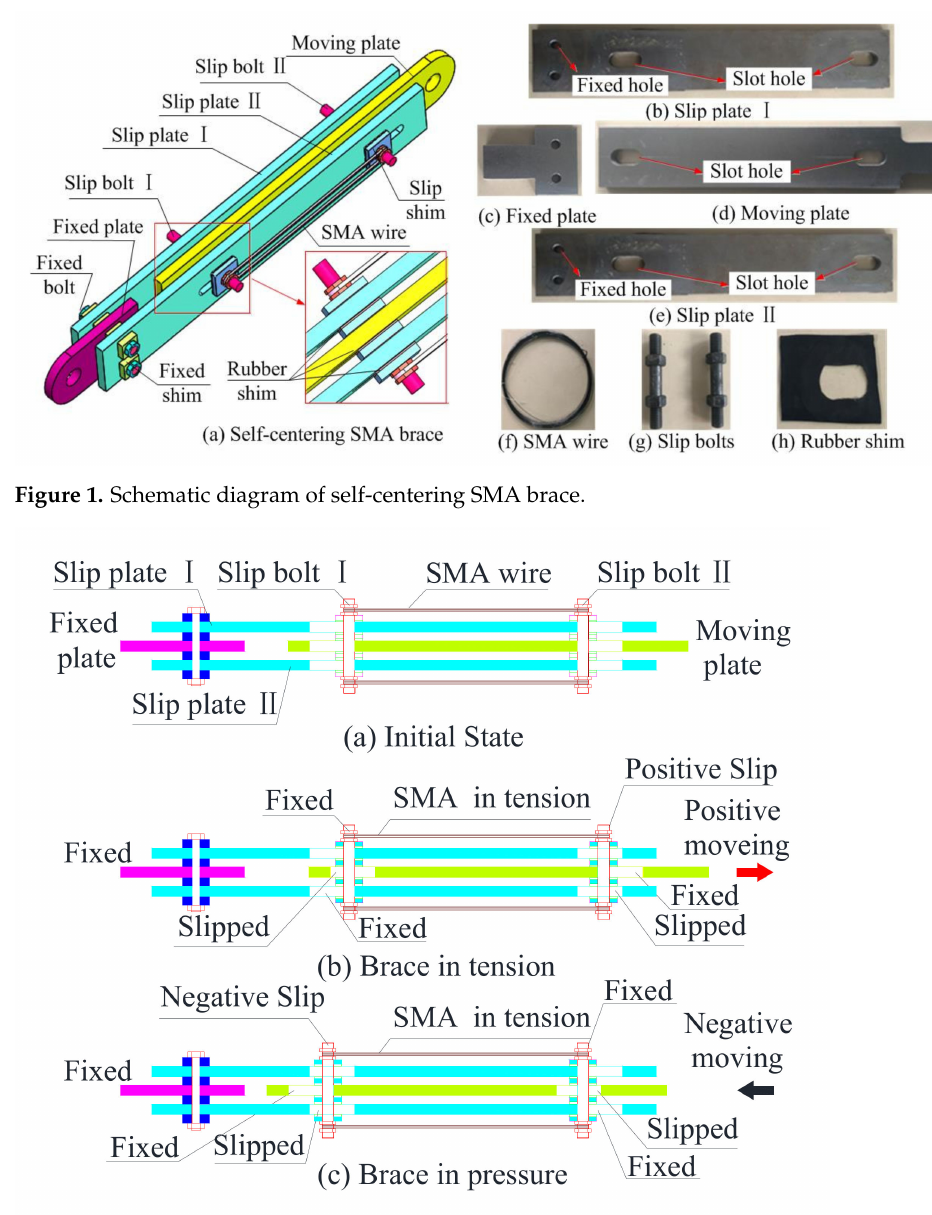
Figure 2. ( a ) initial state, ( b ) brace in tension, ( c ) brace in pressure, Work principle of self-centering SMA